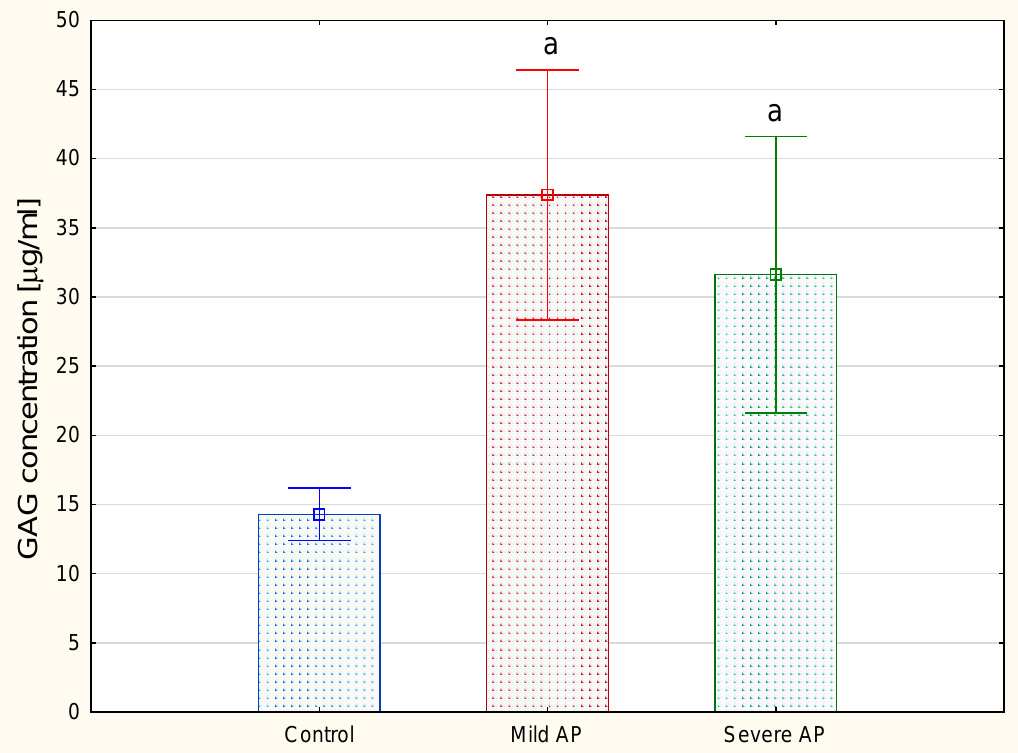
Figure 2. Total concentrations of glycosaminoglycans (GAGs) in the plasma of the healthy controls and the patients with mild or severe acute pancreatitis (AP). GAGs were isolated from plasma samples as described in Section 2 and were quantified by measuring the hexuronate concentration. Data are presented as means ± SD. a—differences statistically significant ( p < 0.05) compared to the healthy controls.